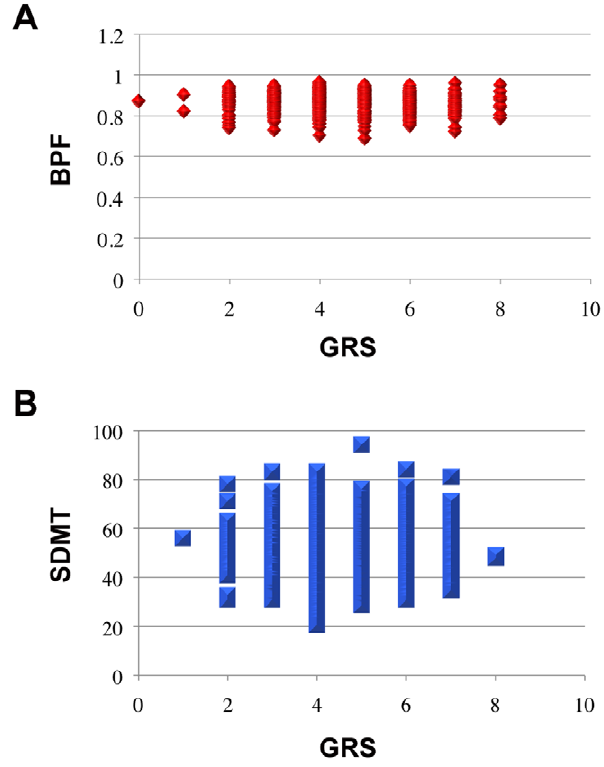
Figure 2. Genetic risk score and baseline outcome. Genetic risk score (GRS) for AD is calculated based on the number of AD-associated risk alleles at the five tested loci borne by each subject. GRS is not correlated with either ( A ) baseline brain parenchymal fraction (BPF, n=722, P =0.096) or ( B ) baseline cognition (SDMT, n=318, P =0.20).